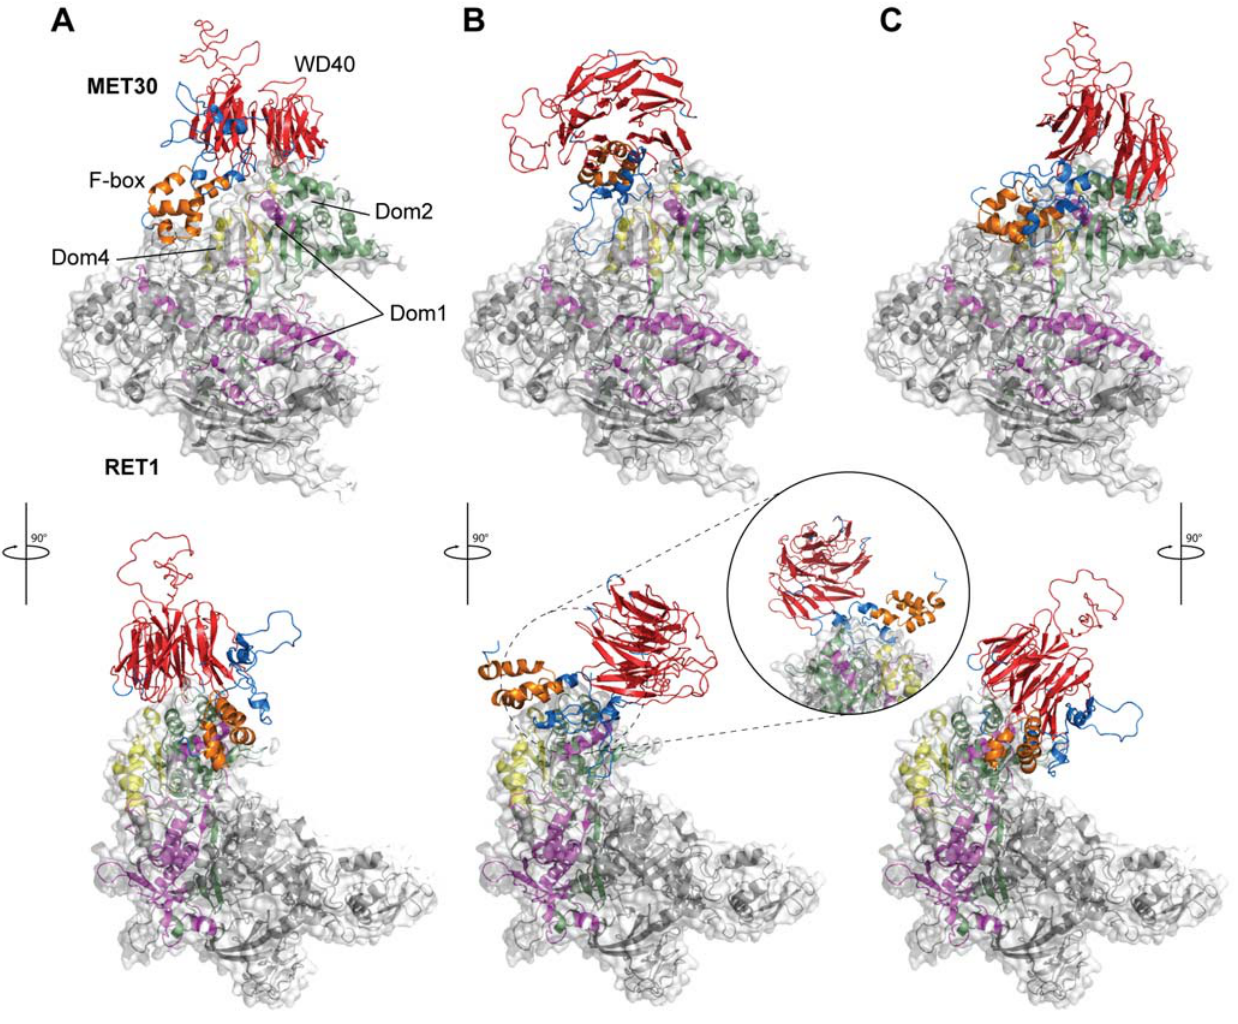
Figure 4. Docking MET30 and RET1, a component of RNA polymerase III. Prediction of the docking between RET1 (grey surface representation) and MET30 (cartoon representation on top). The three top predictions are shown in (A), (B) and (C). Domains of RET 1 are colored in magenta (Dom1), green (dom2) and yellow (dom3) while domains in MET30 are colored in orange (F-box) and red (WD40).